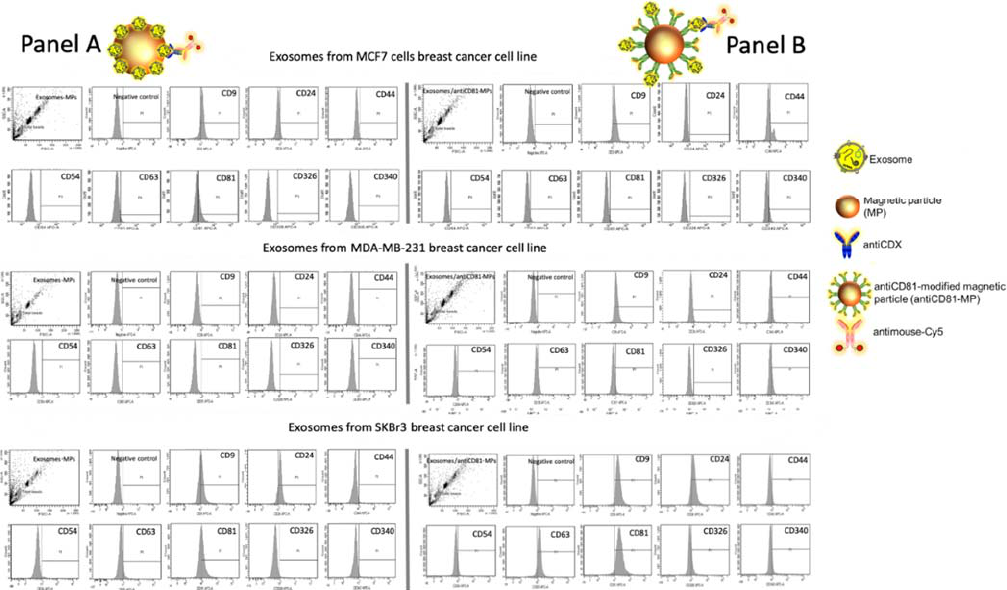
Figure 7. Flow cytometry study for exosomes derived from MCF7, MDA ‐ MB ‐ 231 and SKBr3 breast cancer cell lines attached on magnetic particles (MPs), being (Panel A) covalent immobilization of the exosomes on MPs (exosomes ‐ MPs) and (Panel B) IMS of the exosomes on antiCD81 ‐ MPs, followed by indirect labeling with mouse antiCDX (5 µ g mL − 1 ), (CDX being either CD9, CD24, CD44, CD54, CD63, CD81, CD326 or CD340 biomarkers) and antimouse ‐ Cy5 (2 μ g mL − 1 ). The concentrations of MPs and exosomes were set at 1 × 10 6 MPs and 4 × 10 9 exosomes per assay, respectively.